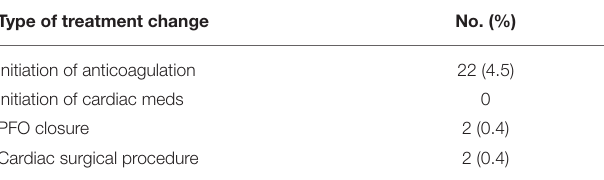
TABLE 5 | Types of treatment